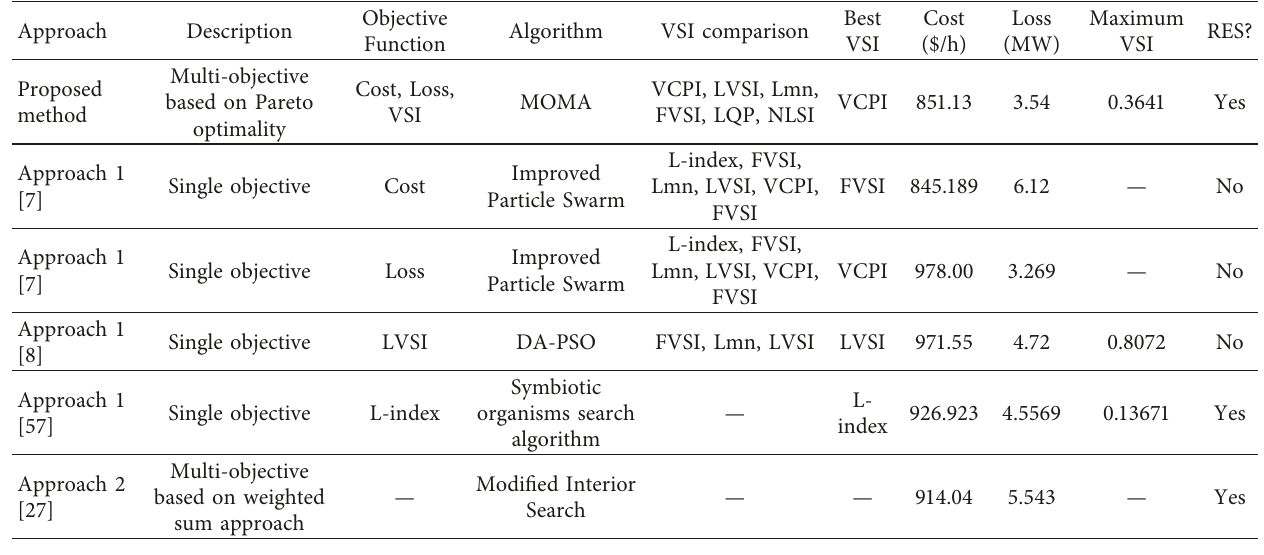
Table 12: Validation of the proposed approach.